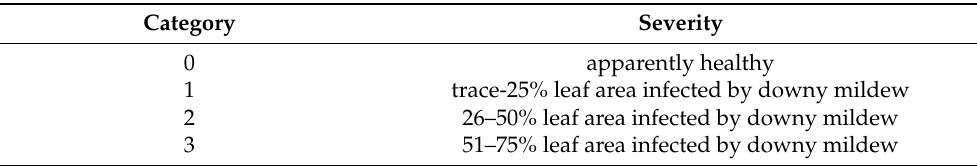
Table 1. Disease severity scale as a percentage of leaf area infected, adapted from